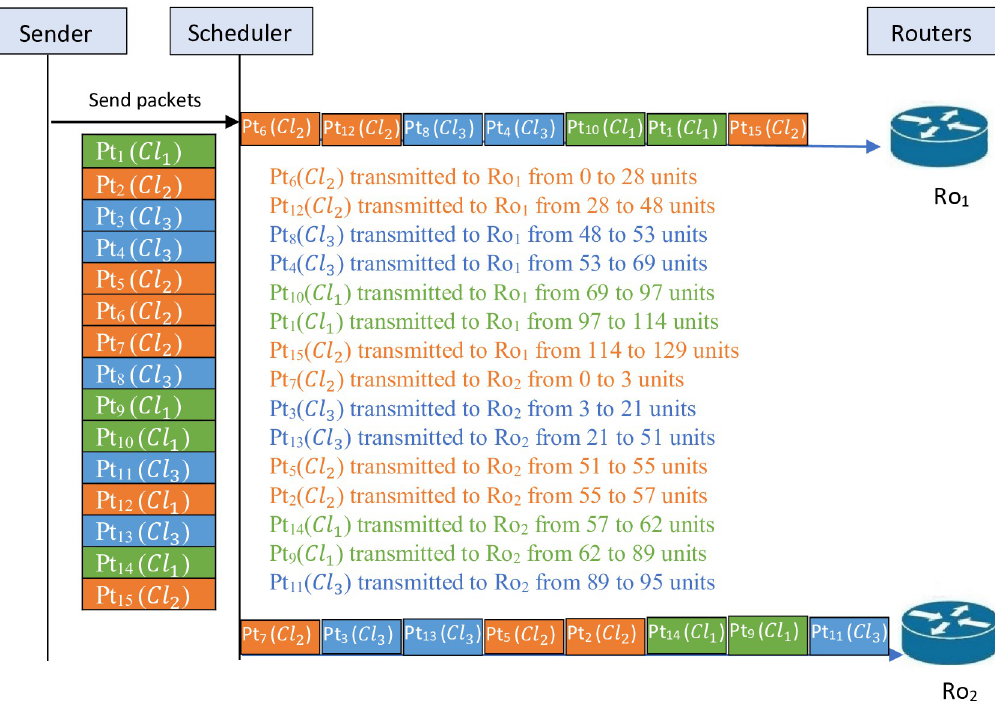
Fig 1. Unfeasible schedule for the studied